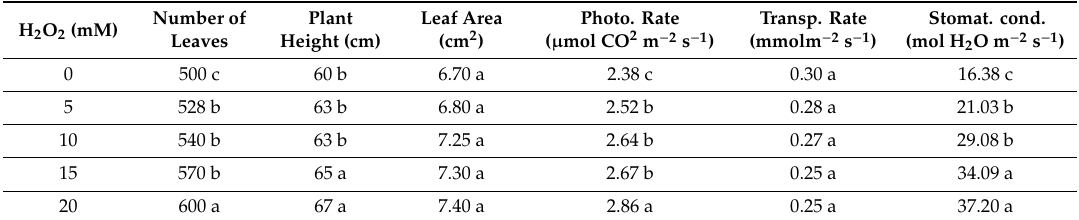
Table 1. The e ff ects of H 2 O 2 treatment on growth and physiological characteristics of Ficus deltoidea plants. Means within the di ff erent line followed by the same letter (a, b, c), did not di ff er significantly according to Tukey HSD test at α =